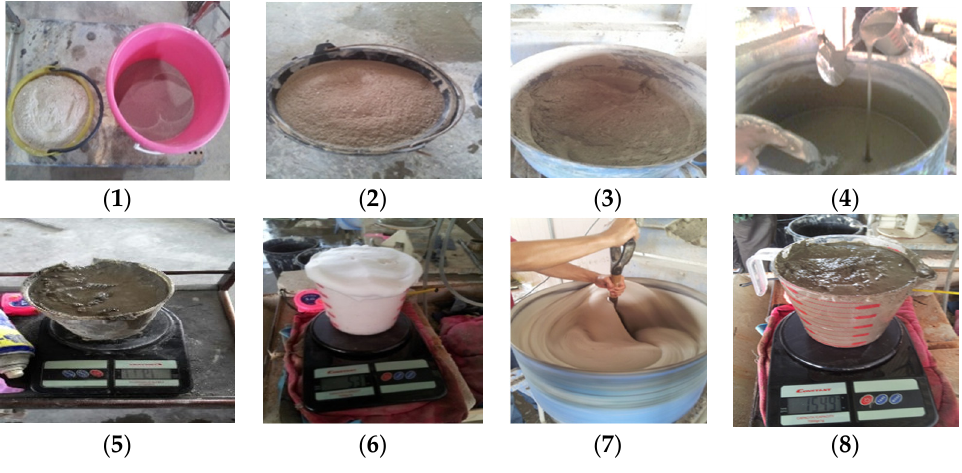
Figure 2. Production of foamed concrete.